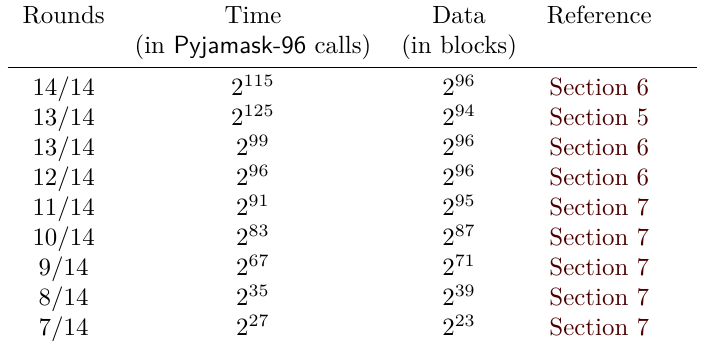
Table 1: Overview of the results on our key recovery attacks on Pyjamask-96 .